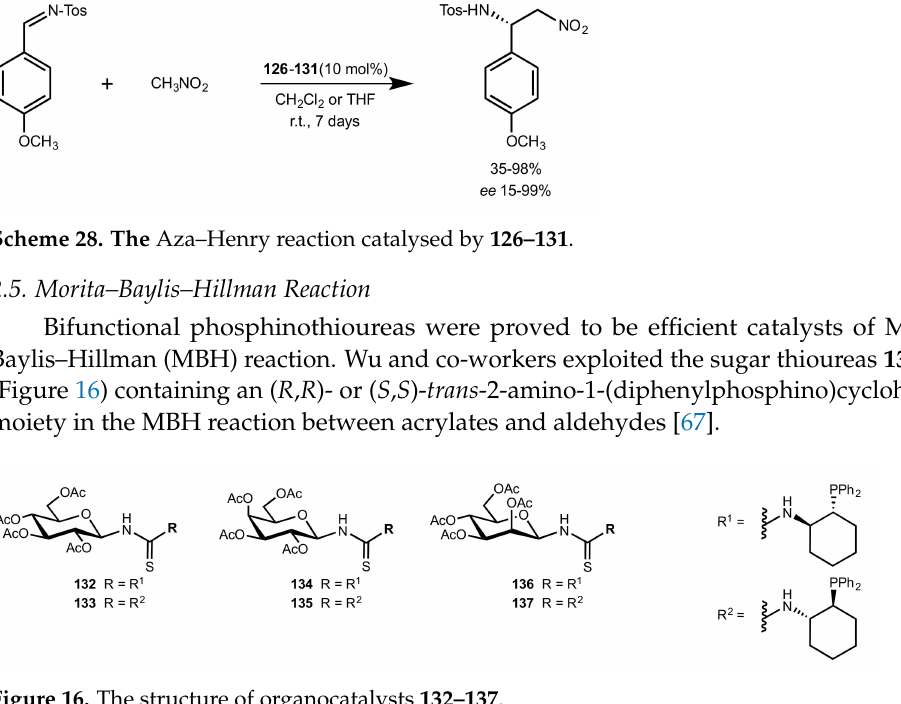
Figure 16. The structure of organocatalysts 132–137